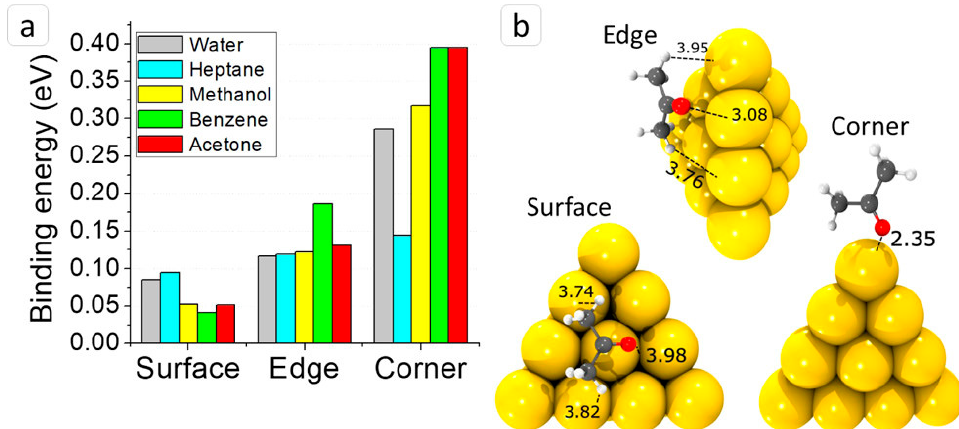
Figure 7. DFT calculation results: ( a ) binding energies of all analytes to the gold cluster Au 20 at three sides, and ( b ) geometry of acetone molecule adsorption on Au 20 surface, edge, and corner. Reproduced from [120] with permission from the American Chemical Society, copyright 2020. Table 1. List of recently developed sensors using nanoarchitectonics.